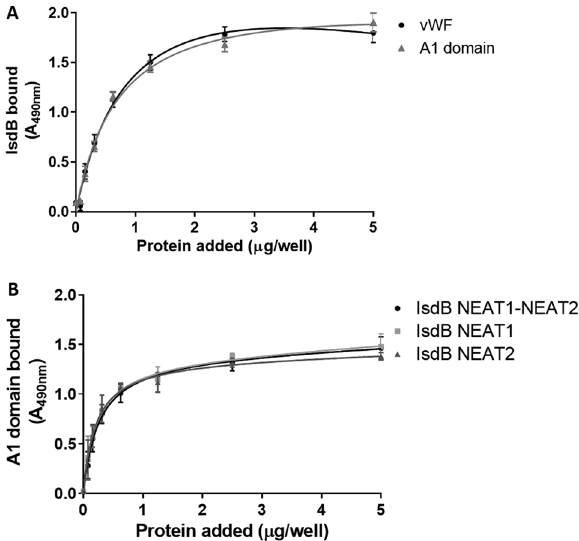
Figure 5. Localization of the binding sites involved in the interaction of IsdB with vWF. (A) Concentration dependent-binding of IsdB NEAT1-NEAT2 to immobilized vWF or the vWF A1 domain. vWF and the recombinant A1 domain were immobilized onto microtiter wells and incubated with increasing concentrations of IsdB NEAT1-NEAT2. Complex formation was detected by addition to the wells of a polyclonal rabbit anti- IsdB IgG followed by HRP-conjugated goat anti-rabbit IgG. (B) Binding of the A1 domain to IsdB proteins. IsdB NEAT1–NEAT2 protein and its NEAT1 and NEAT2 subregions were immobilized onto microtiter wells and incubated with increasing concentrations of the A1 domain. Ligand binding was detected as reported in Fig. 1C. The data points are the means ± SD from three independent experiments, each performed in